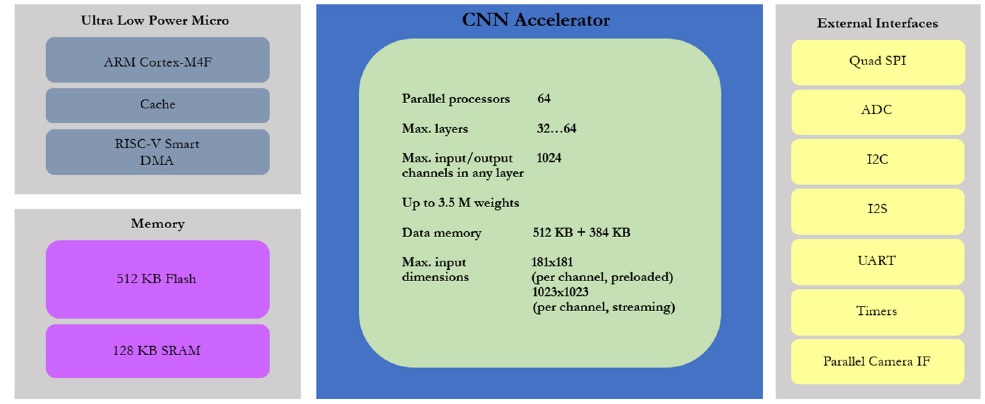
Figure 1. The architecture of